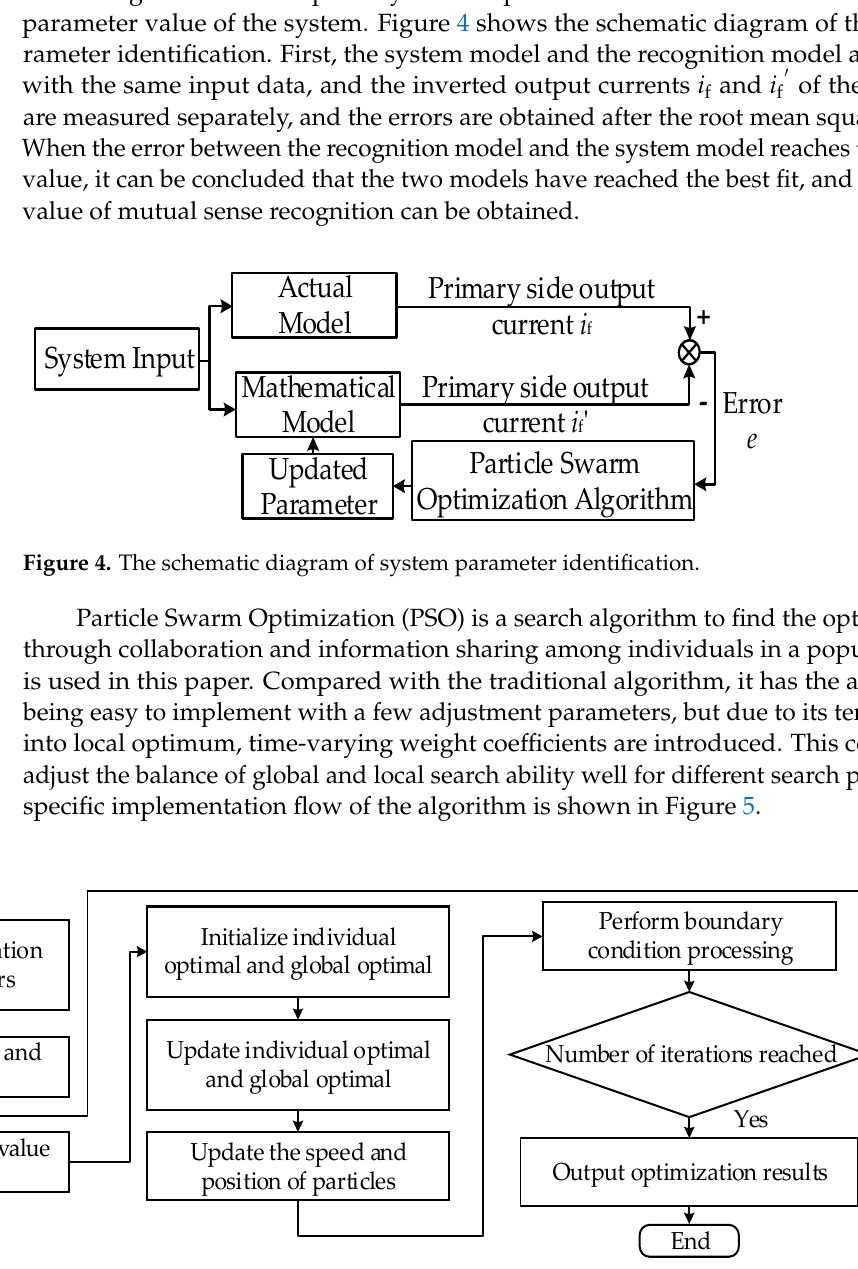
( c ) Figure 3. Waveforms of i0 and i 0′ at each conduction angle of the input voltage. ( a ) Voltage conduction angle 90°; ( b ) Voltage conduction angle 120°; ( c ) Voltage conduction angle 180°. In Figure 3a – c, because the input voltage conduction angle is different, it leads to a different amplitude of the voltage and the cycle time is changed. As the conduction angle increases, the voltage amplitude increases and the time of one cycle decreases. As can be seen from Figure 3, when the system reaches the resonant state and in three different input voltage signal cases, the waveforms of the mathematical model and the physical model